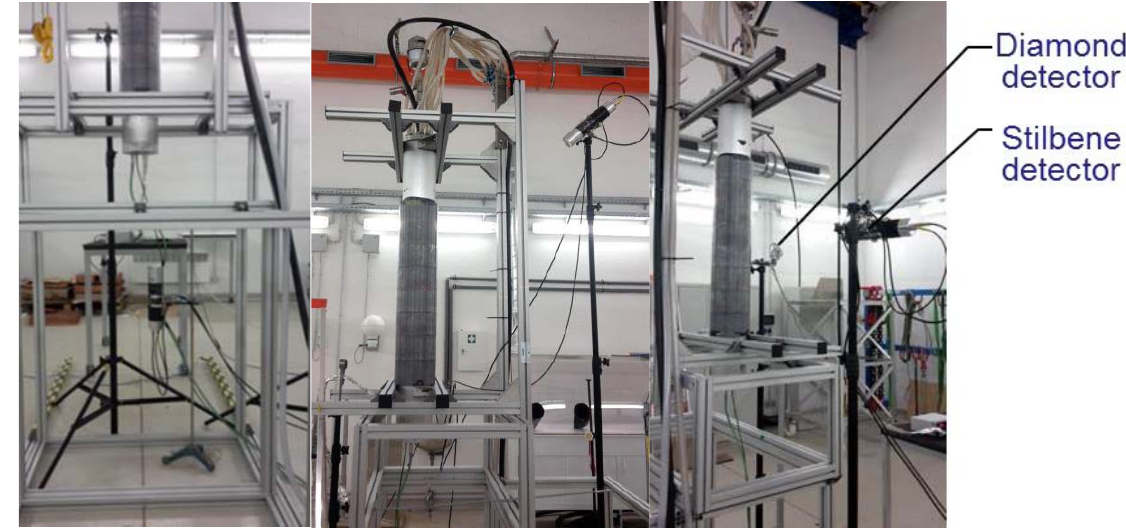
Figure 3. NG with a stilbene detector and a diamond detector placed in several measurement